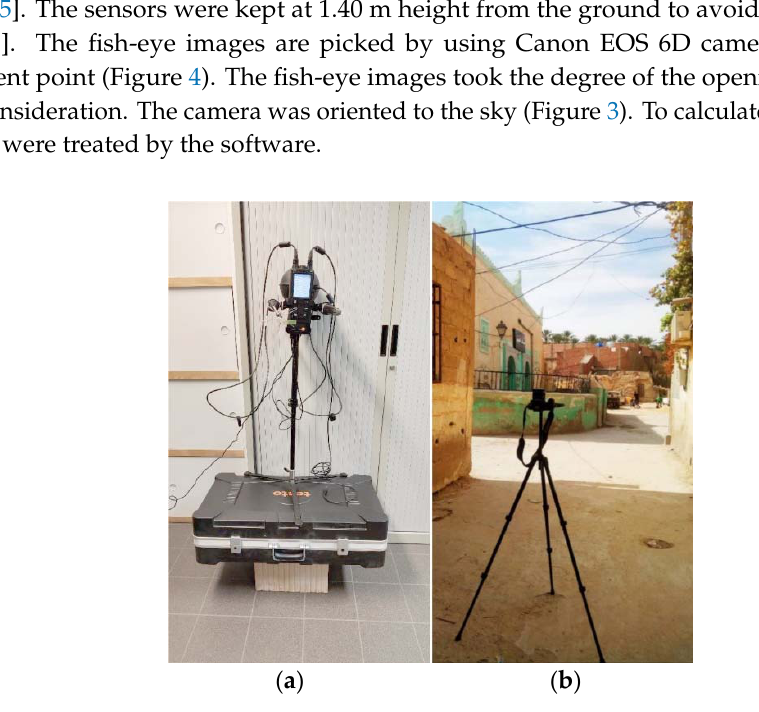
Table 2. Instruments used for the data measurement.